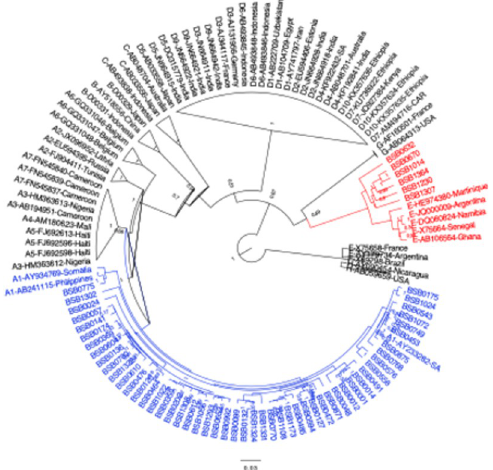
Fig 1. Phylogenetic analysis of 57 partial HBV genomes from Beira, Mozambique. Genotype A sequences from Mozambique are shown in blue, while genotype E/A recombinant sequences are highlighted in red. GenBank reference sequences are indicated by their genotype/subtype, accession number, and country of origin. Relevant posterior probabilities > 0.90 out of 1.00 are shown. The scale bar indicates 0.03 nucleotide substitutions per site.